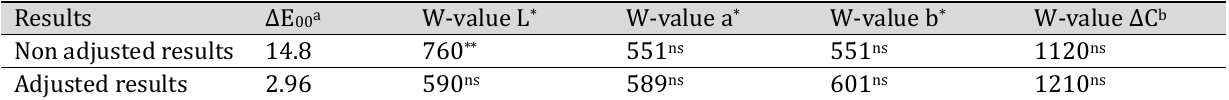
Table 3. Statistical analysis results for comparing the standard chromameter values with the values obtained by the developed system before and after adjustment according to MLR prediction